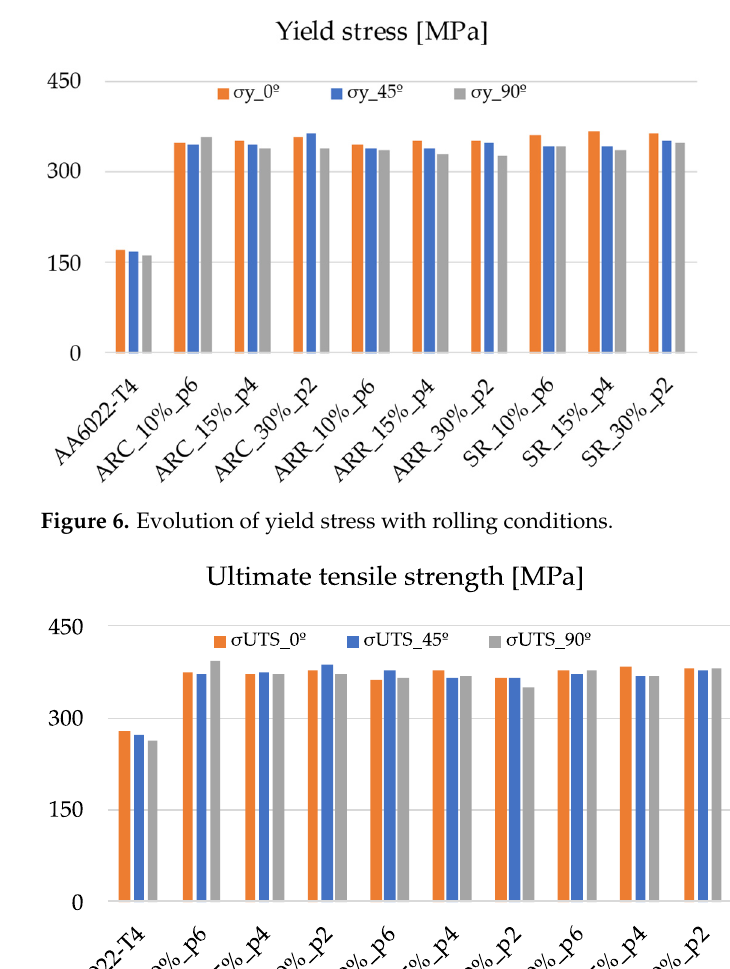
Figure 9. Evolution of total deformation with rolling conditions. 4.1.3. Anisotropy As presented in the Introduction, several authors suggest that ASR is capable of im ‐ proving the plastic anisotropy of material, i.e., the normal anisotropy increases, whereas the planar anisotropy decreases. The Lankford coefficient was measured at the end of each type of rolling in three directions, namely 0°, 45°, and 90°. A summary of the results is presented in Figure 10. The initial material presents the highest R values for 0°, with a minimum at 45°. After rolling, the minimum R values remain at 45°, whereas the maxi ‐ mum values increase to 90°. This evolution of R values is observed for all rolling routes except one, i.e., ARC with 30 reductions per pass in two passes. In this case, the minimum occurs at 0°. Such behavior of the Lankford coefficient is related to the texture evolution during the rolling process. The texture evolution is beyond the scope of this work, in which anisotropy is analyzed from a macroscopic point of view. Using the Lankford co ‐ efficients, the average value of normal anisotropy ( 𝑅(cid:3364) value) and the planar anisotropy ( Δ R) were calculated for all rolling routes. These results are presented in Figures 11 and 12, respectively. The lowest value of 𝑅(cid:3364) corresponds to ARR routes, resulting in materials similar characteristics to those of the as ‐ received material. For ARC and SR, a small in ‐ crease in 𝑅(cid:3364) ‐ value is obtained. The planar anisotropy shows a drop for all rolling routes, with the minimum corresponding to ARC. In addition, it seems that the planar anisotropy is also related to the number of passes and the thickness reduction per pass used in each